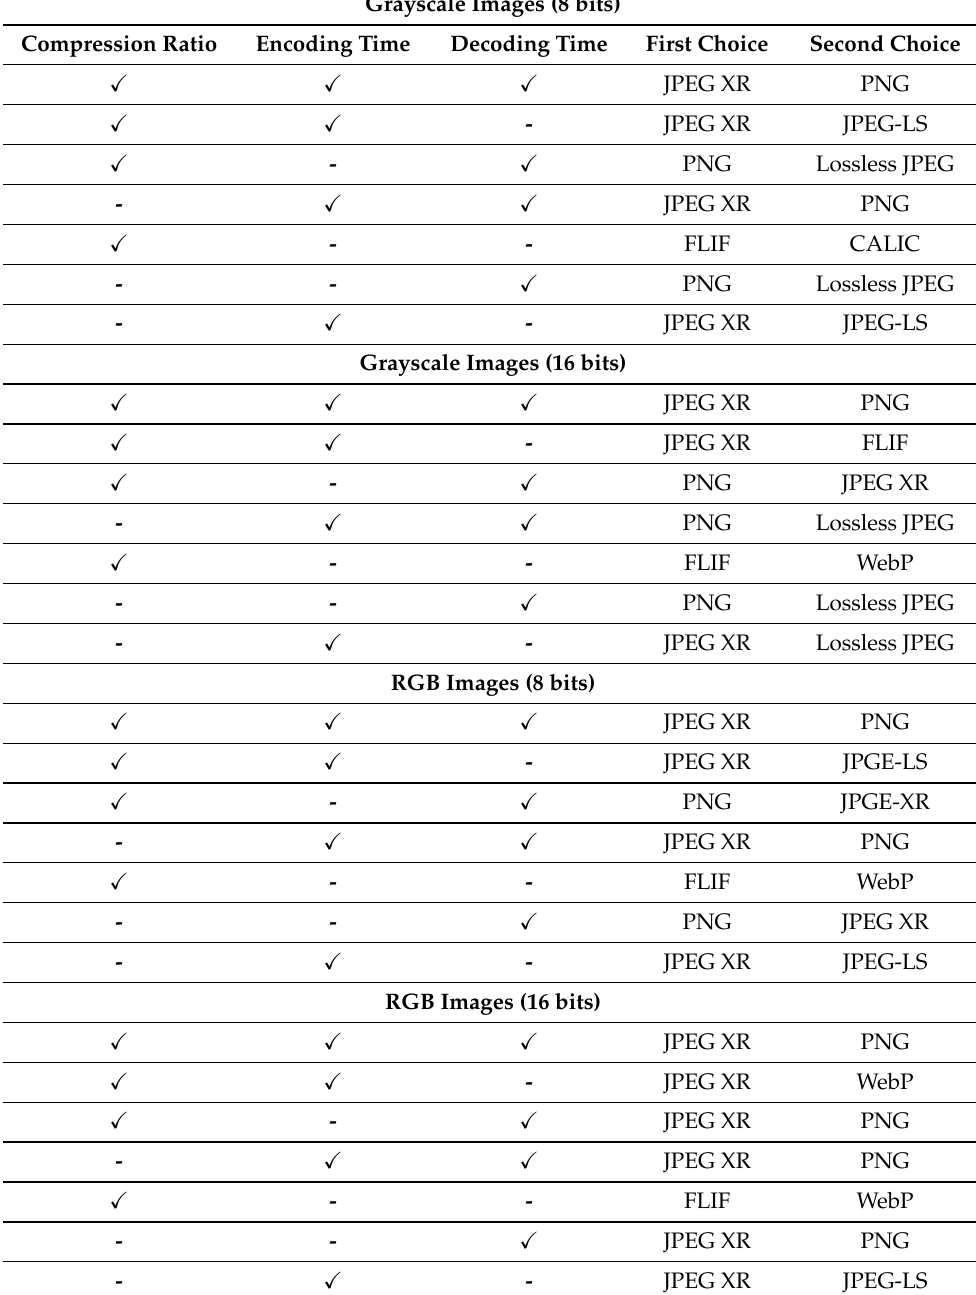
Table 9. Summary of